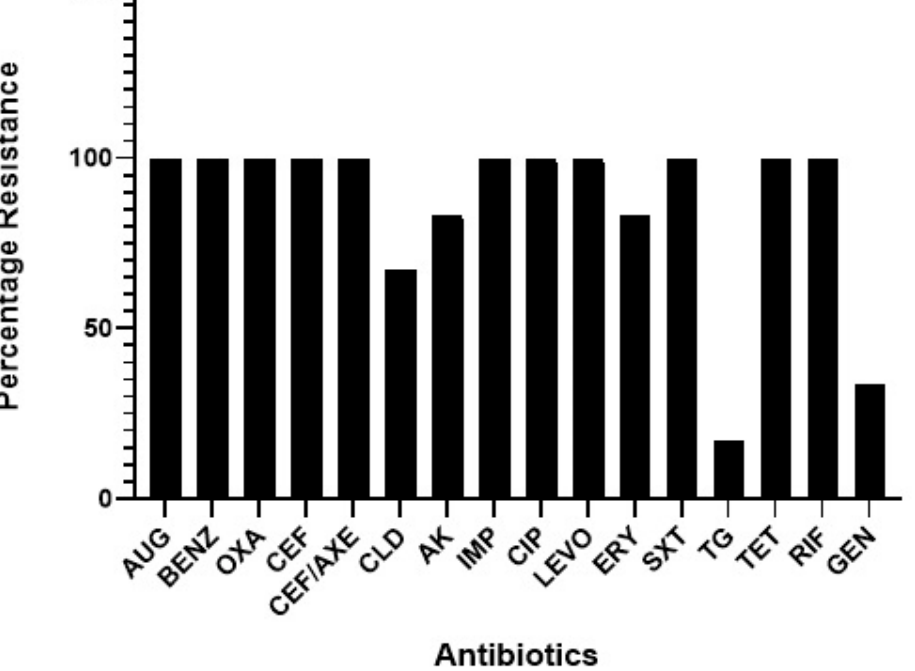
Figure 1. Antimicrobial resistance of methicillin-resistant Staphylococcus aureus . Augmentin (AUG), benzyl penicillin (BENZ), oxacillin (OXA), cefuroxime (CEF), cefuroxime/axetil (CEF/AXE), clindamycin (CLD), amikacin (AK), imipenem (IMP), ciprofloxacin (CIP), levofloxacin (LEVO), erythromycin (ERY), sulfamethoxazole/trimethoprim (SXT), tigecycline (TG), tetracycline (TET), rifampicin (RIF), and gentamicin (GEN). Table 1. Minimum inhibitory concentration of the MRSA isolates against tested antibiotics. Antibiotic